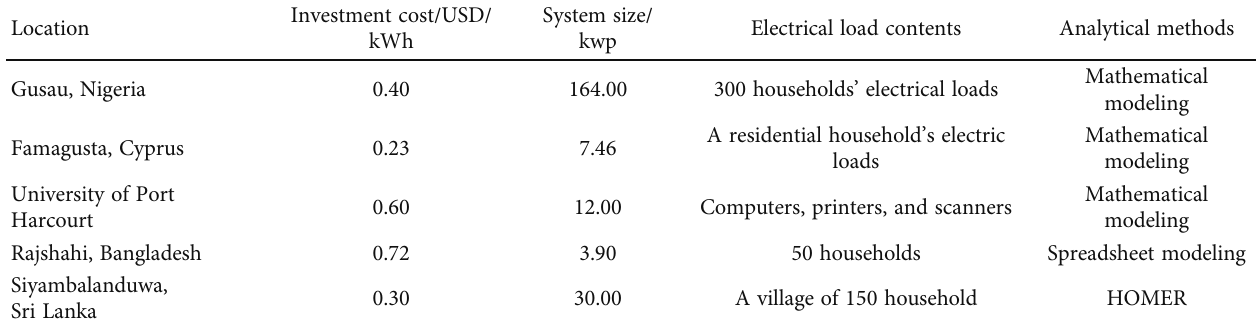
Table 1: Solar PV